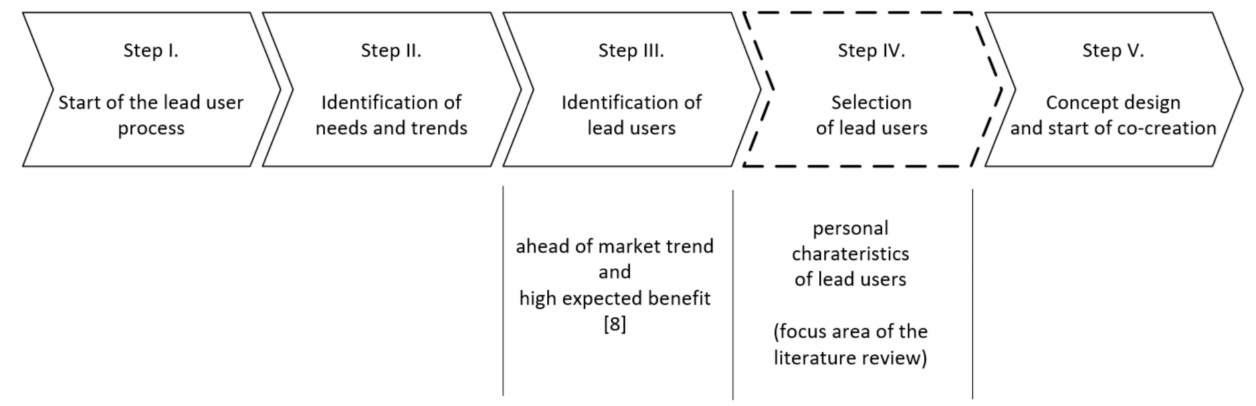
Figure 1. Extended lead-user method concerning the focus area of the literature